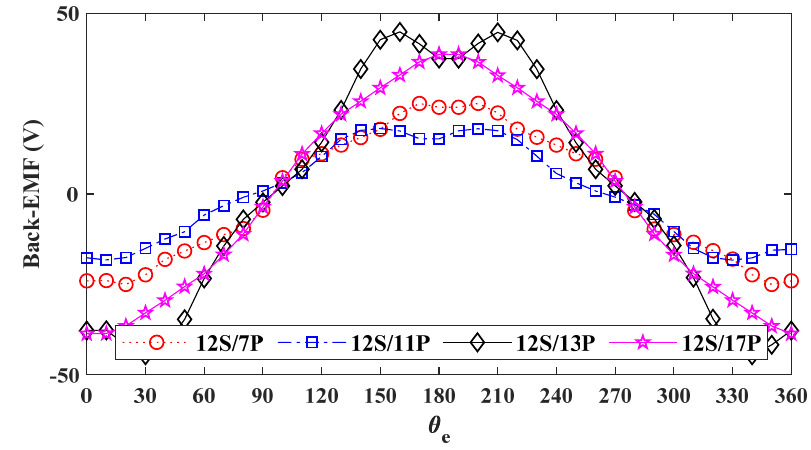
Figure 5. No-load operation phase back-EMF.